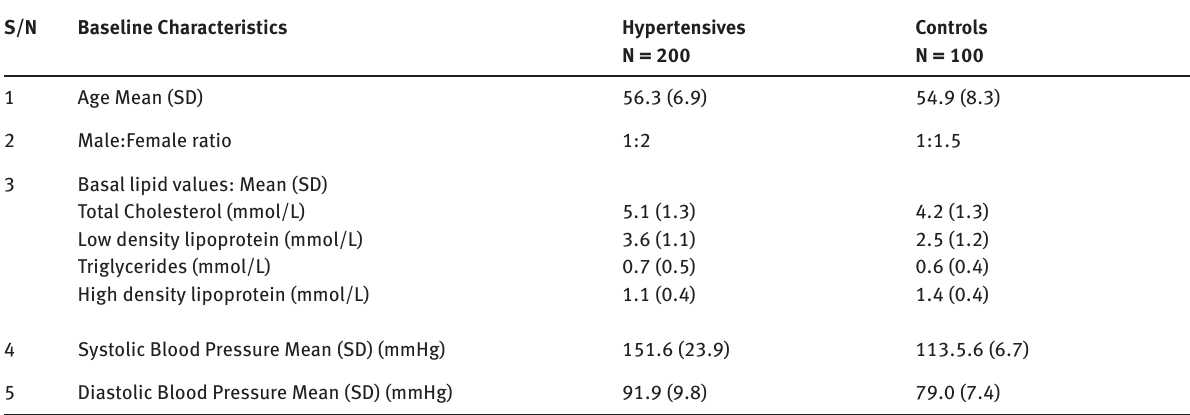
Table 1: Baseline Characteristics of Study Groups. This table describes the age, male-to-female ratio, basal lipid values and systolic and diastolic blood pressure values of the study